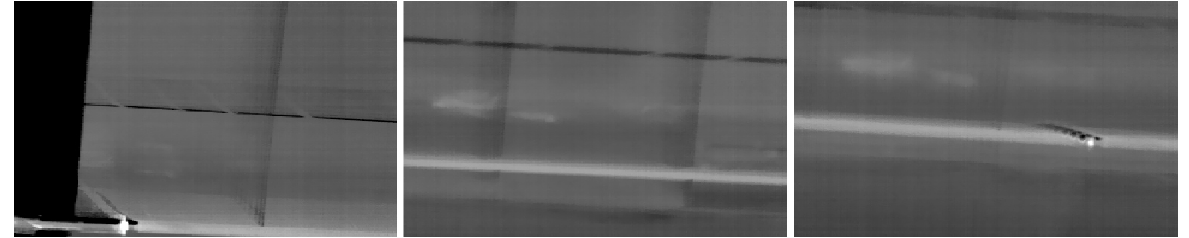
Figure 6. Sequence of thermographic images on Valle